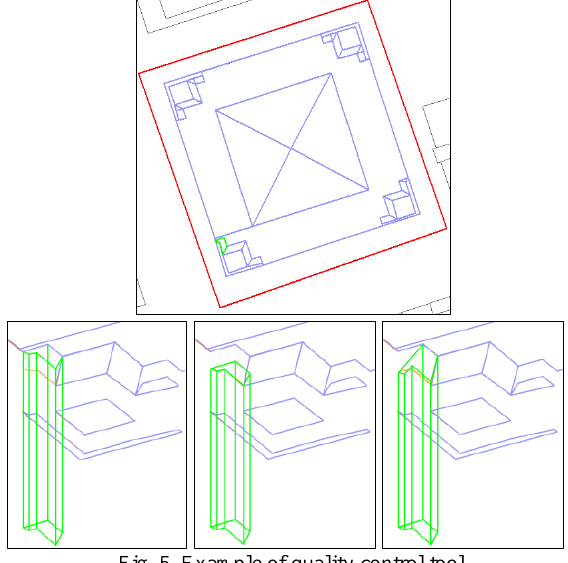
Fig. 5. Example of quality control